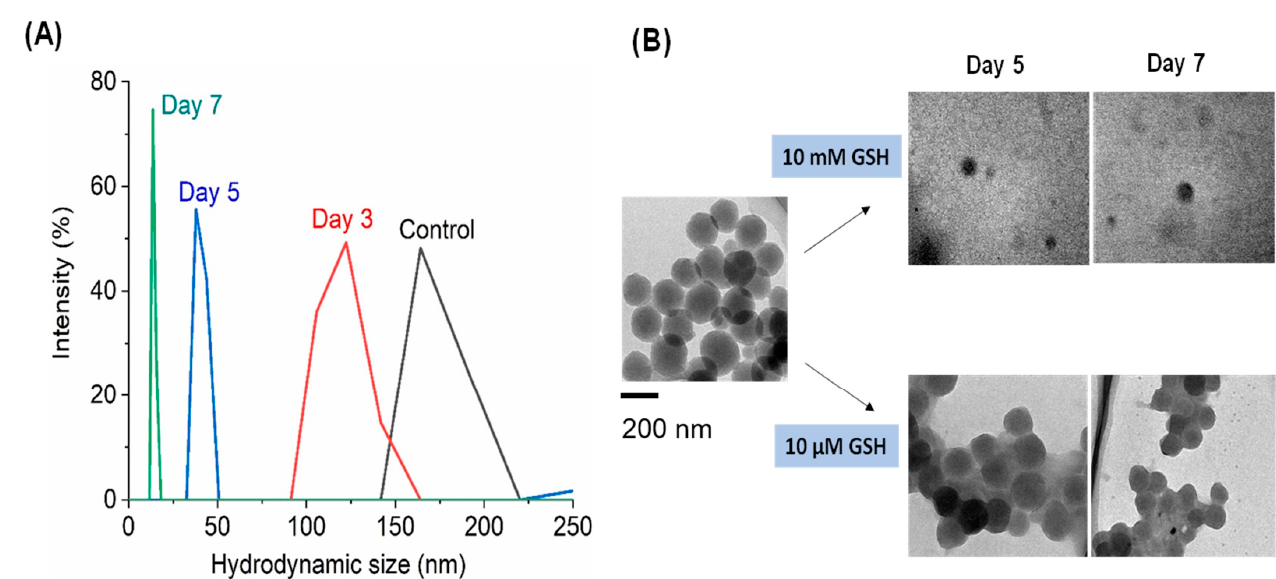
Figure 2. Degradation of BPMO nanoparticles in the presence of 10 mM glutathione (GSH) was investigated by examining nanoparticle size by dynamic light scattering analysis (DLS) ( A ) as well as by TEM analysis ( B ). Little degradation was observed after incubation with 10 μ M GSH.